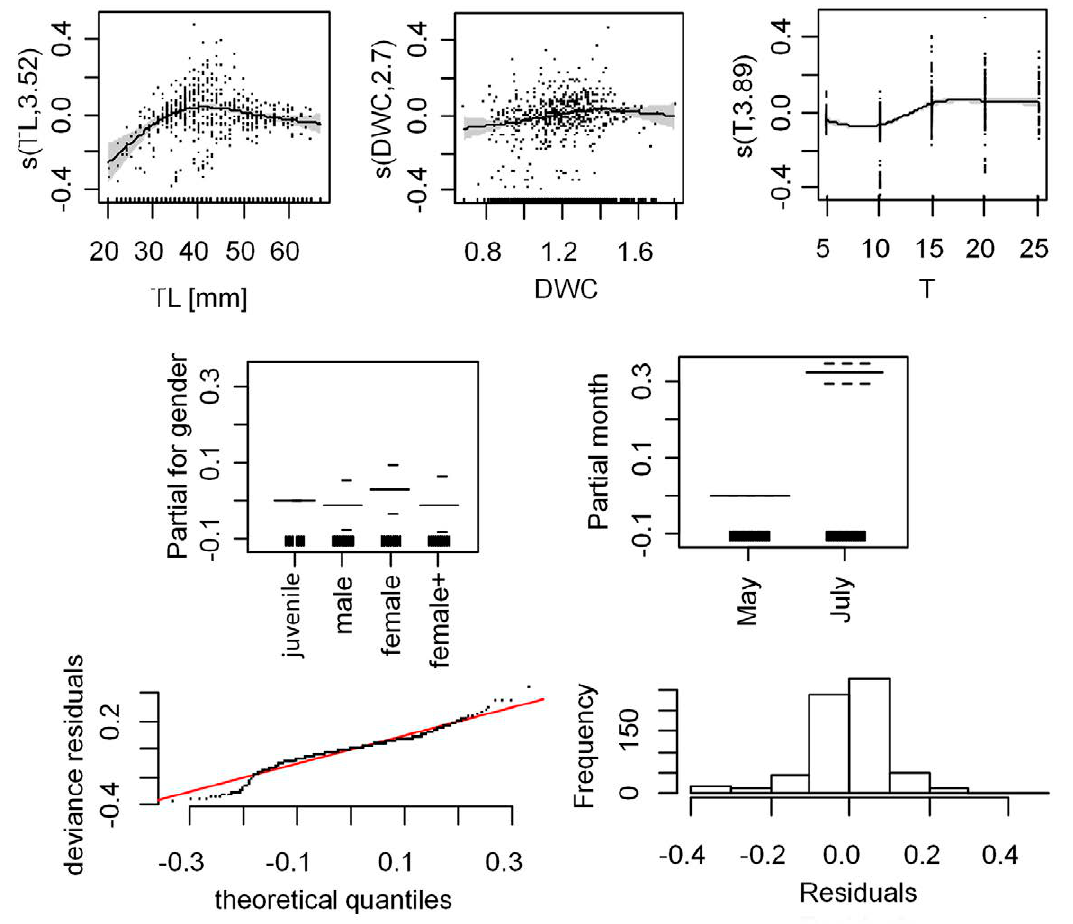
Fig. 3. – Results of the generalized additive model. Partial residuals for growth vs. length (top left), dry weight condition (top middle), tem- perature (top right), sex (middle left), sampling month (middle right), and distribution of the residuals (lower